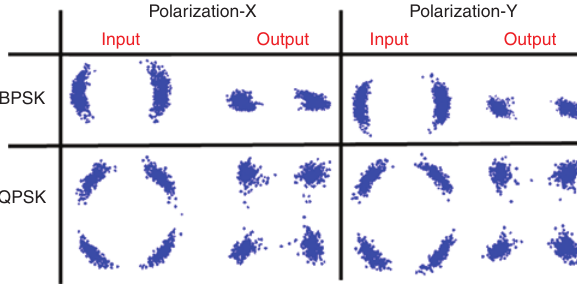
Figure 24: Non-degenerate PSA phase squeezing